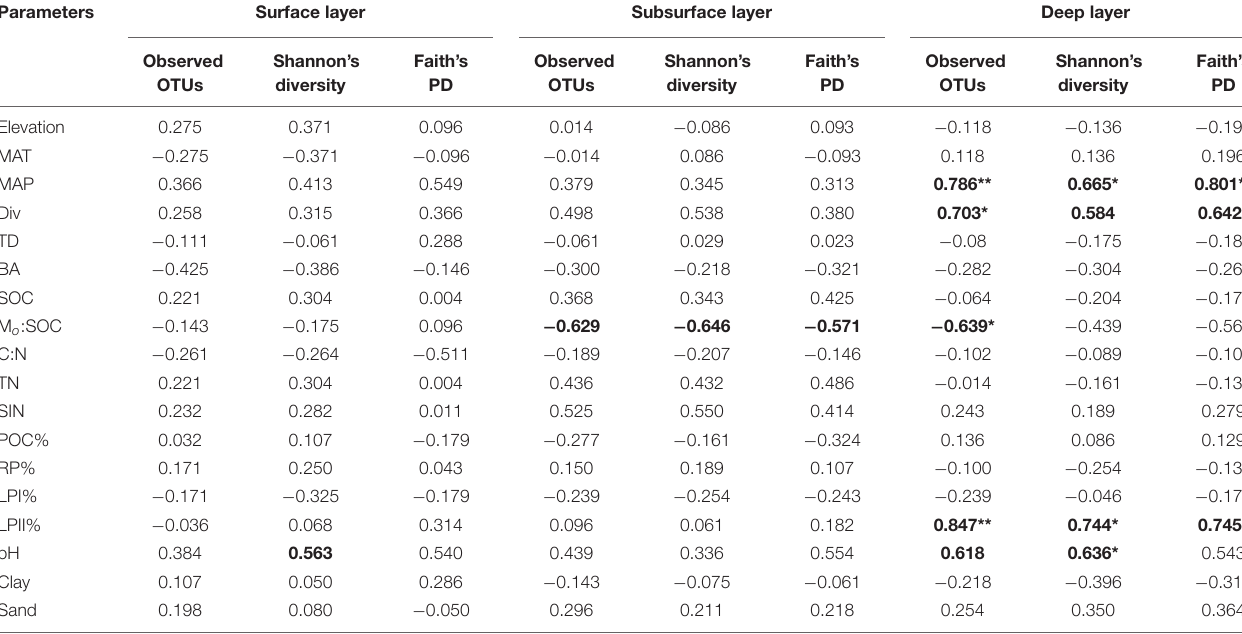
Dissimilarity matrices of the environmental characteristics were calculated based on Euclidean distances. Numbers in bold indicate significant relationships at p < 0.1. *p < 0.05; **p < 0.01. p-Values were corrected for multiple testing using the Benjamini and Hochberg method. MAT, mean annual temperature; MAP, mean annual precipitation; Div, Shannon’s index of trees; BA, the sum of the breast-height basal areas of trees; TD, tree density; SIN, soil inorganic nitrogen (NH 4 + + NO 3 − ); POC%, proportion of particulate organic carbon in SOC; LPI%, proportion of labile carbon I in SOC; LPII%, proportion of labile carbon II in SOC; RP% proportion of recalcitrant carbon in SOC; M o :SOC, mole ratio of poorly crystallized Fe and Al to